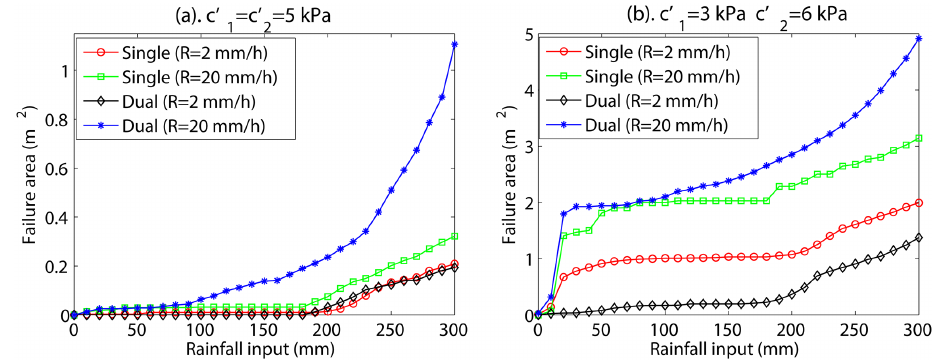
Figure 10. Development of the failure area under different rainfall intensities and soil